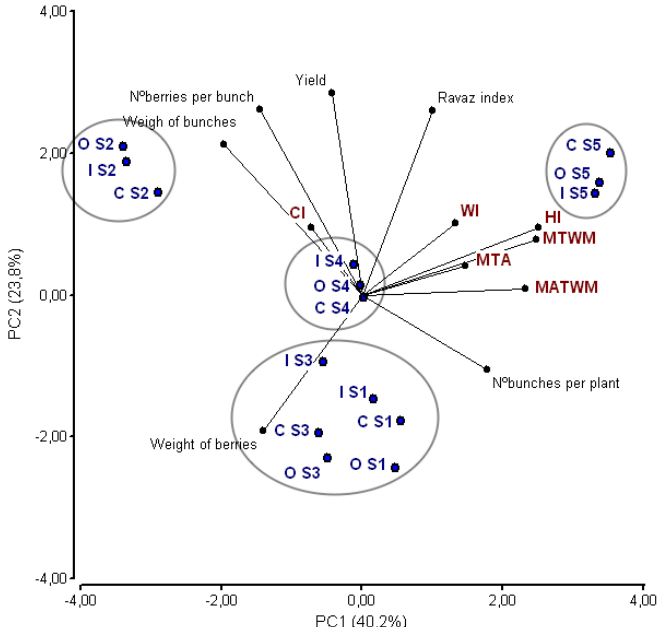
Figure 1. Principal component analysis (PCA) performed with grapevine productive parameter from a Cabernet Sauvignon vineyard planted in an organic (O), integrated (I), and conventional (C) managements, together with different bioclimatic indices such as cool night index (CI), Huglin’s Heliothermal Index (HI), mean thermal amplitude (MTA), Winkler Index (WI), average mean temperature of the warmest month (MTWM), and maximum average temperature of the warmest month (MATWM) along five consecutive seasons (S).